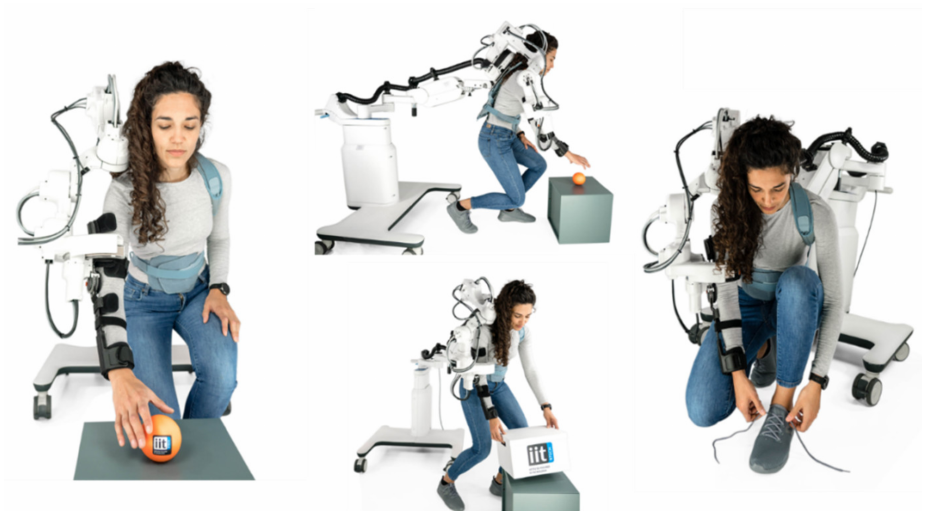
Figure 7. Transparency mode taking advantage of the polyarticulated arm to perform activities of daily